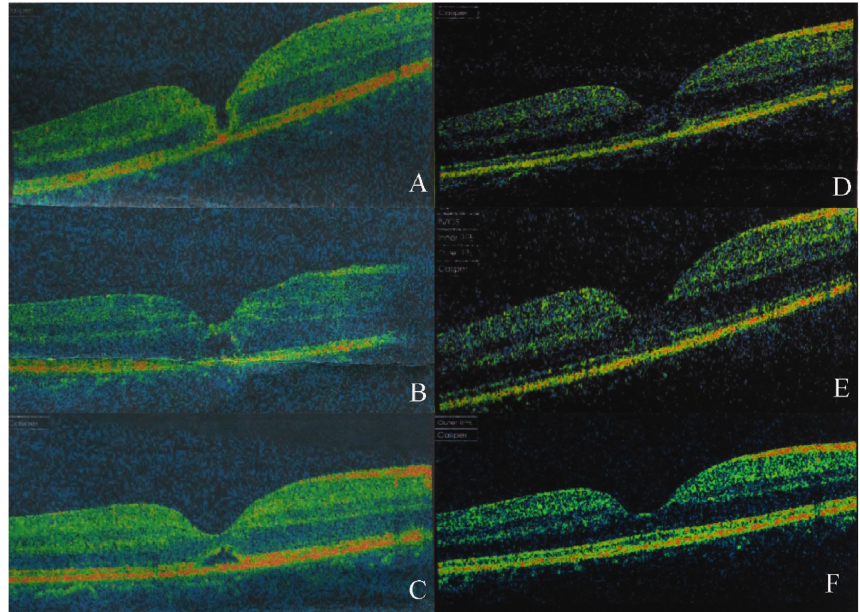
Figure 3: Case 3: a 14-year-old female patient with spontaneous macular hole closure. The patient sustained blunt trauma to the right eye from a firecracker. Her BCVA was 20/125 at initial and improved 120/200 after treatment. (a) OCT image 2 days after trauma showing FTMH. (b) OCTimage 1 week, (c) 1 month, (d) 2 months, and (e) 3 months after trauma showed that a bridge connection has formed in the middle of the hole. (f) OCTimage of 6 months after trauma, showing the neurosensory retina had almost connected, and the ellipsoid band had regained